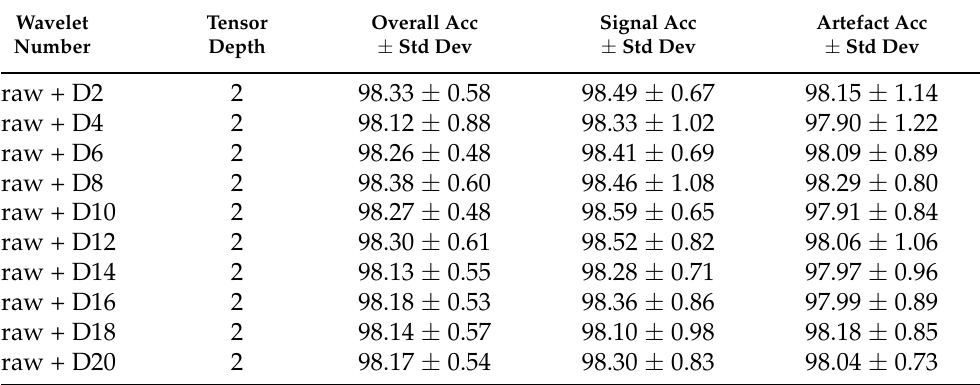
Table 11. Smaller-scale CNN model performance for various single wavelet transformations ap- plied to input data. Results have been estimated using repeated k-fold validation (5 rounds with 5 folds